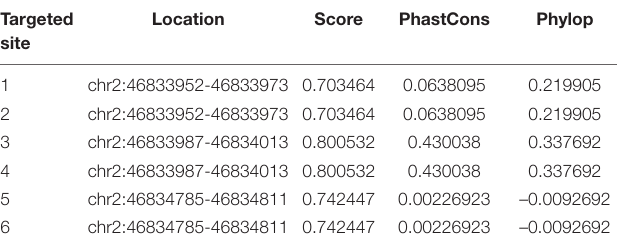
TABLE 2 | Predicted targeted sites of LINC01119 by ELAVL1 in